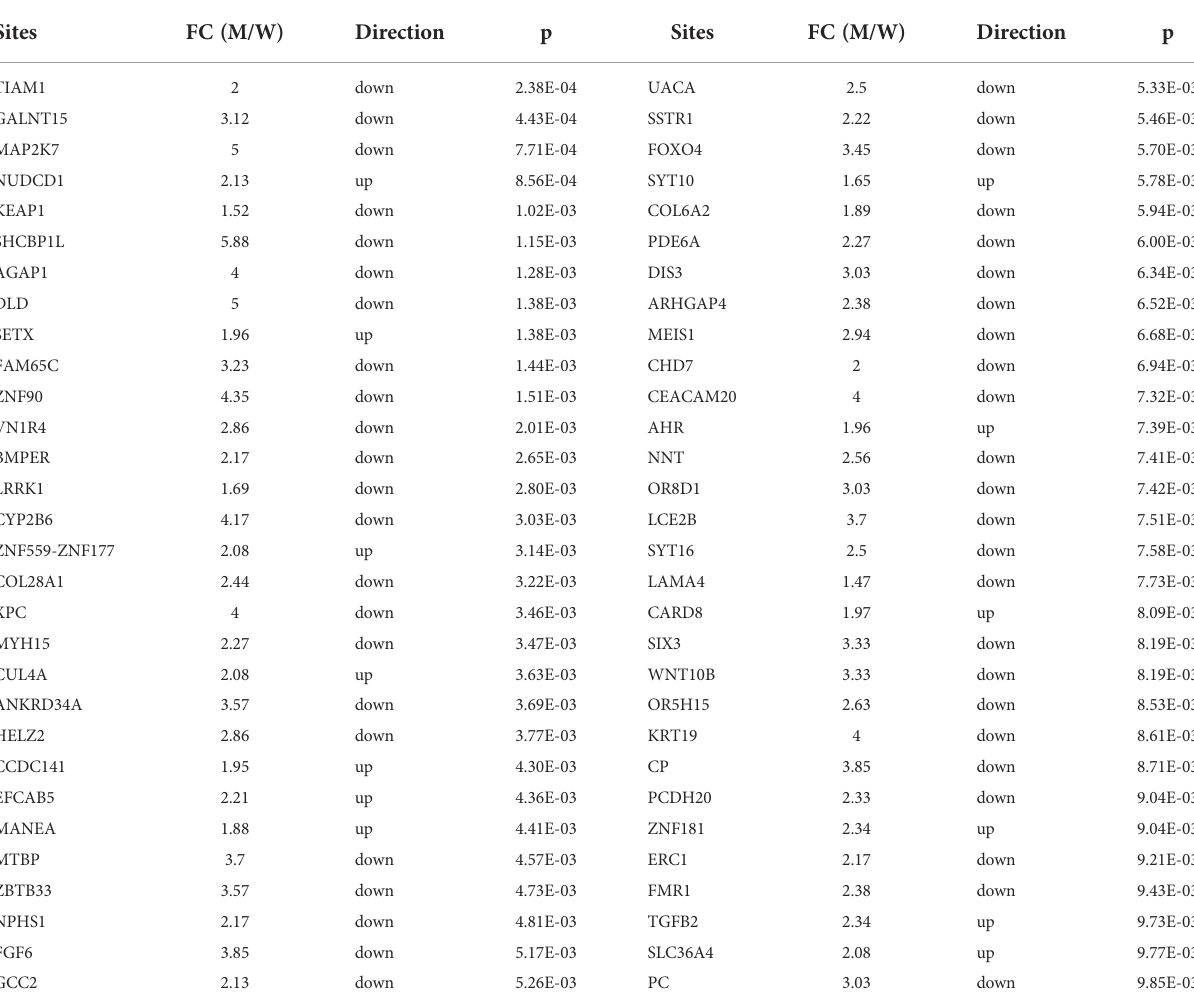
TABLE 1 Expression of TRAT1 in LAC mutation